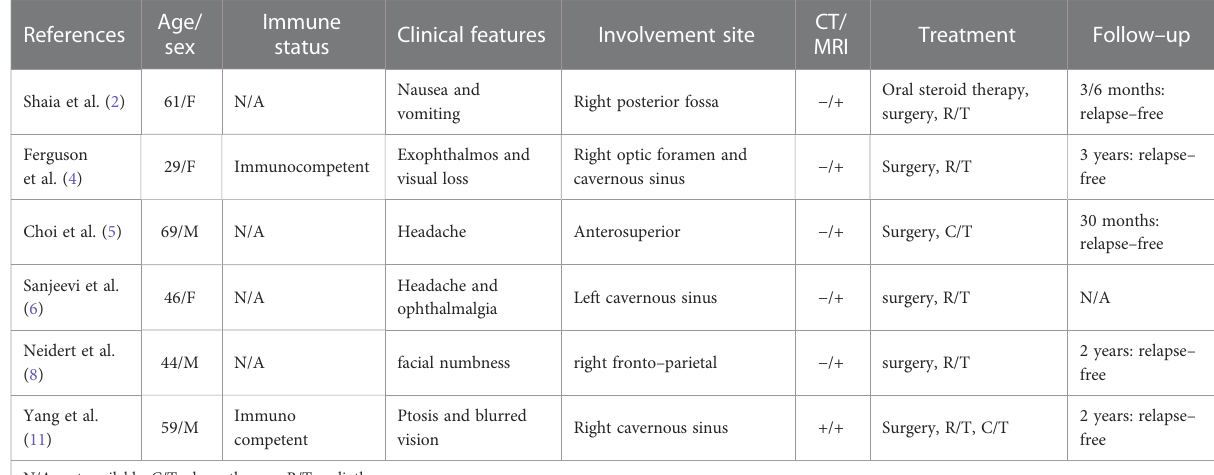
TABLE 1 Summary of Intracranial MALT Lymphomas up to 4 November